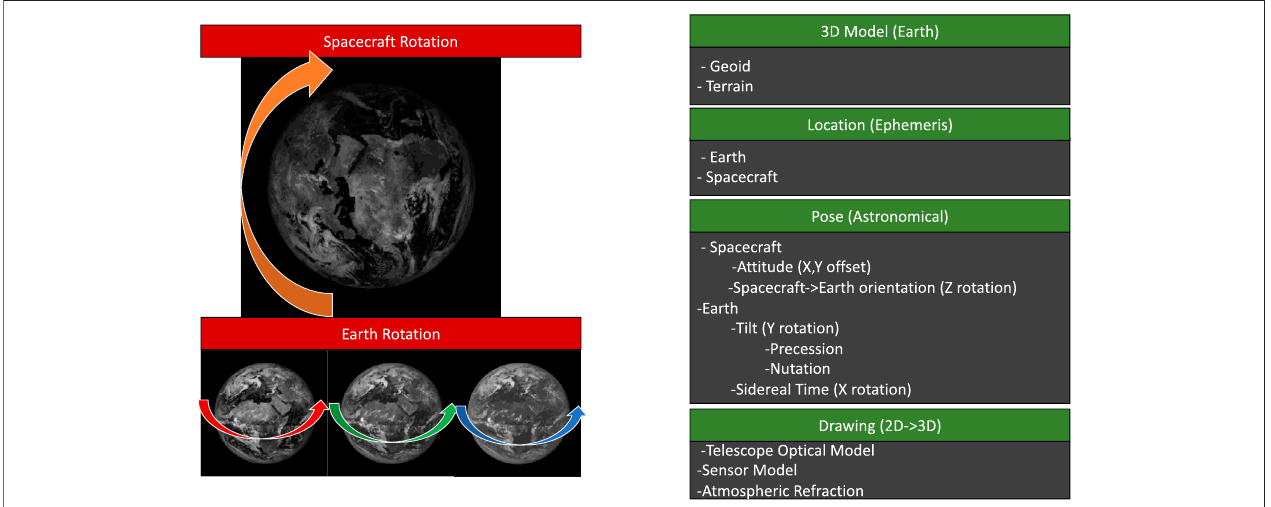
FIGURE 3 | Different corrections made by the EPIC geolocation software and the inputs needed for the different parts of the program.